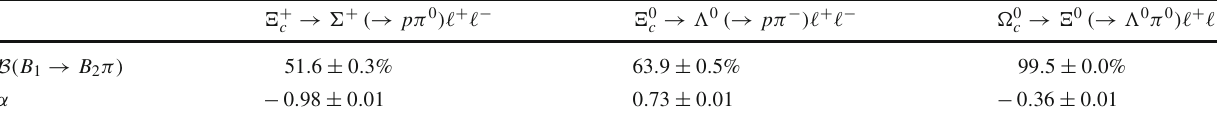
Table 1 Self-analyzing rare charm four-body decays B 0 → B 1 ( → B 2 π)(cid:5) + (cid:5) − and information on the branching ratios and weak decay parameters α of the secondary baryonic B → B π decay [16] 1 2